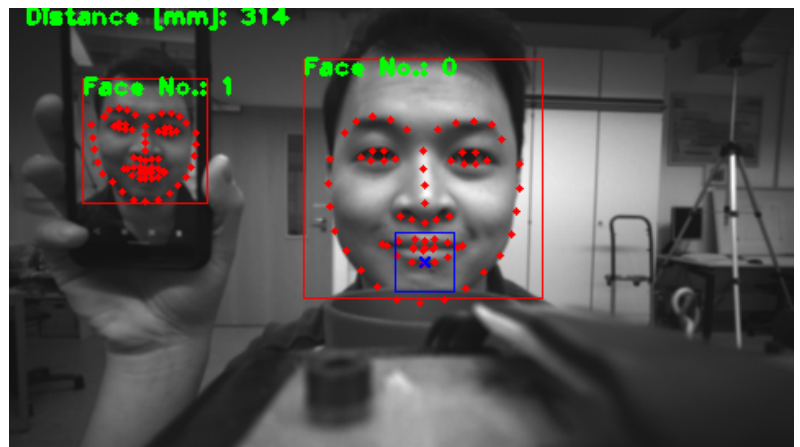
Figure 6. Visual representation of the input data for the sensor alignment estimation. The picture shows a camera image with an overlay of the input data. Two faces are being tracked unambiguously which are labeled as Face No.: 0 and 1. The red dots illustrate the position of the facial landmarks. The projection of the distance measurement is illustrated by the blue cross which is framed by a blue rectangle. The rectangle symbolizes the field of view of the distance sensor. In this picture the distance sensor is not properly aimed at the upper